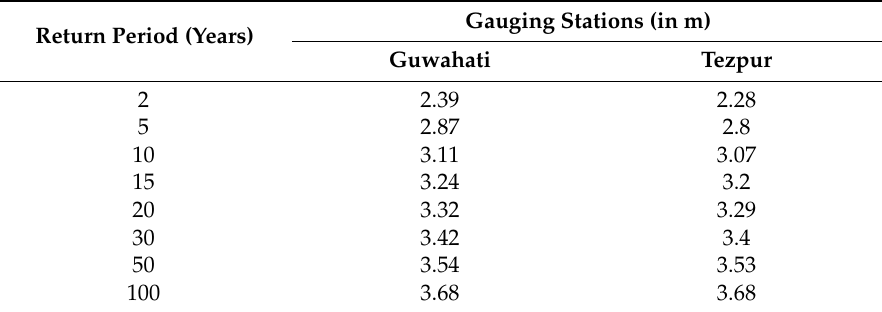
Table 2. Probable lift of flood wave.